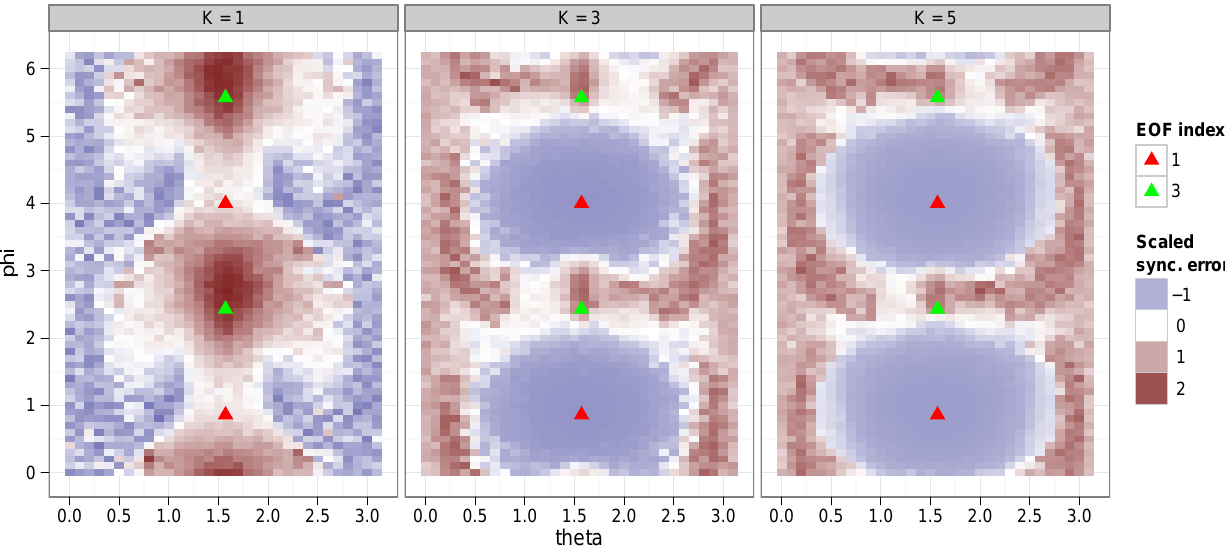
Fig. 2. Plot of the normalized synchronization error h| x 1 − x 2 |i in the θ - ϕ plane. The red triangles show the θ and ϕ coordinates of the first EOF axis, p 1 , the green triangles the coordinates of the third EOF axis, p 3